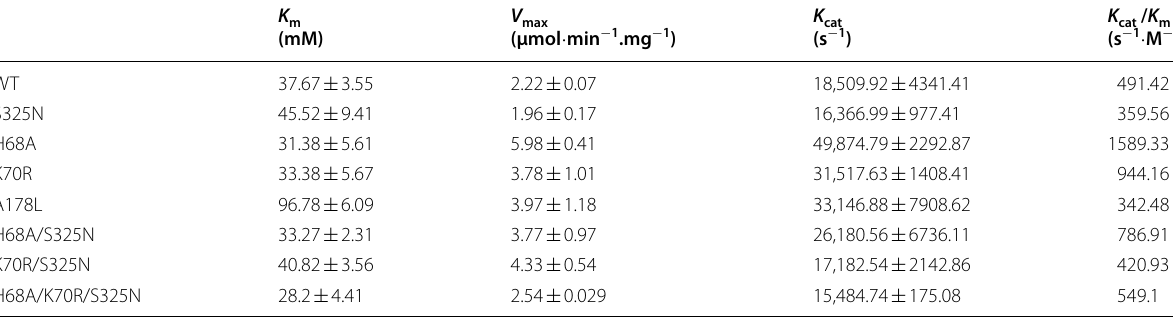
Table 1 Enzymatic kinetic parameters of the three mutant proteins K m